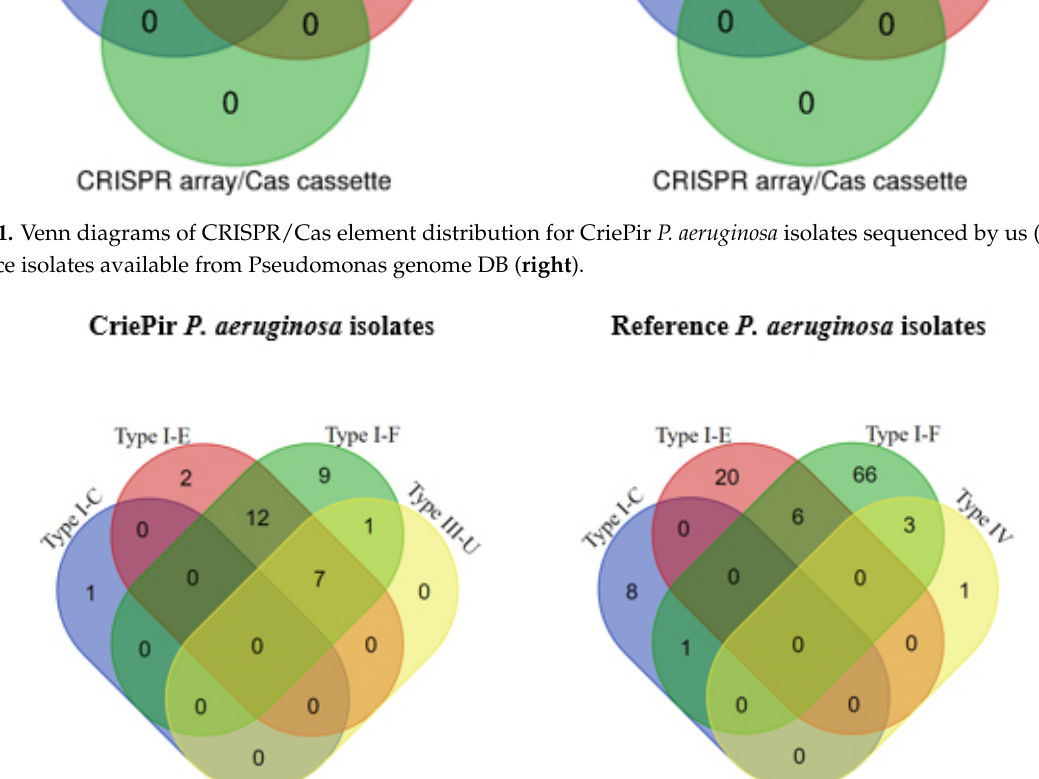
Figure 2. Venn diagrams of CRISPR/Cas system type distribution for CriePir ( left ) and reference ( right ) P. aeruginosa isolates.